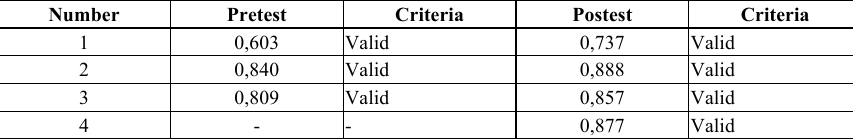
Table 5. Empirical Validity Result of the Pretest and Post-test Material